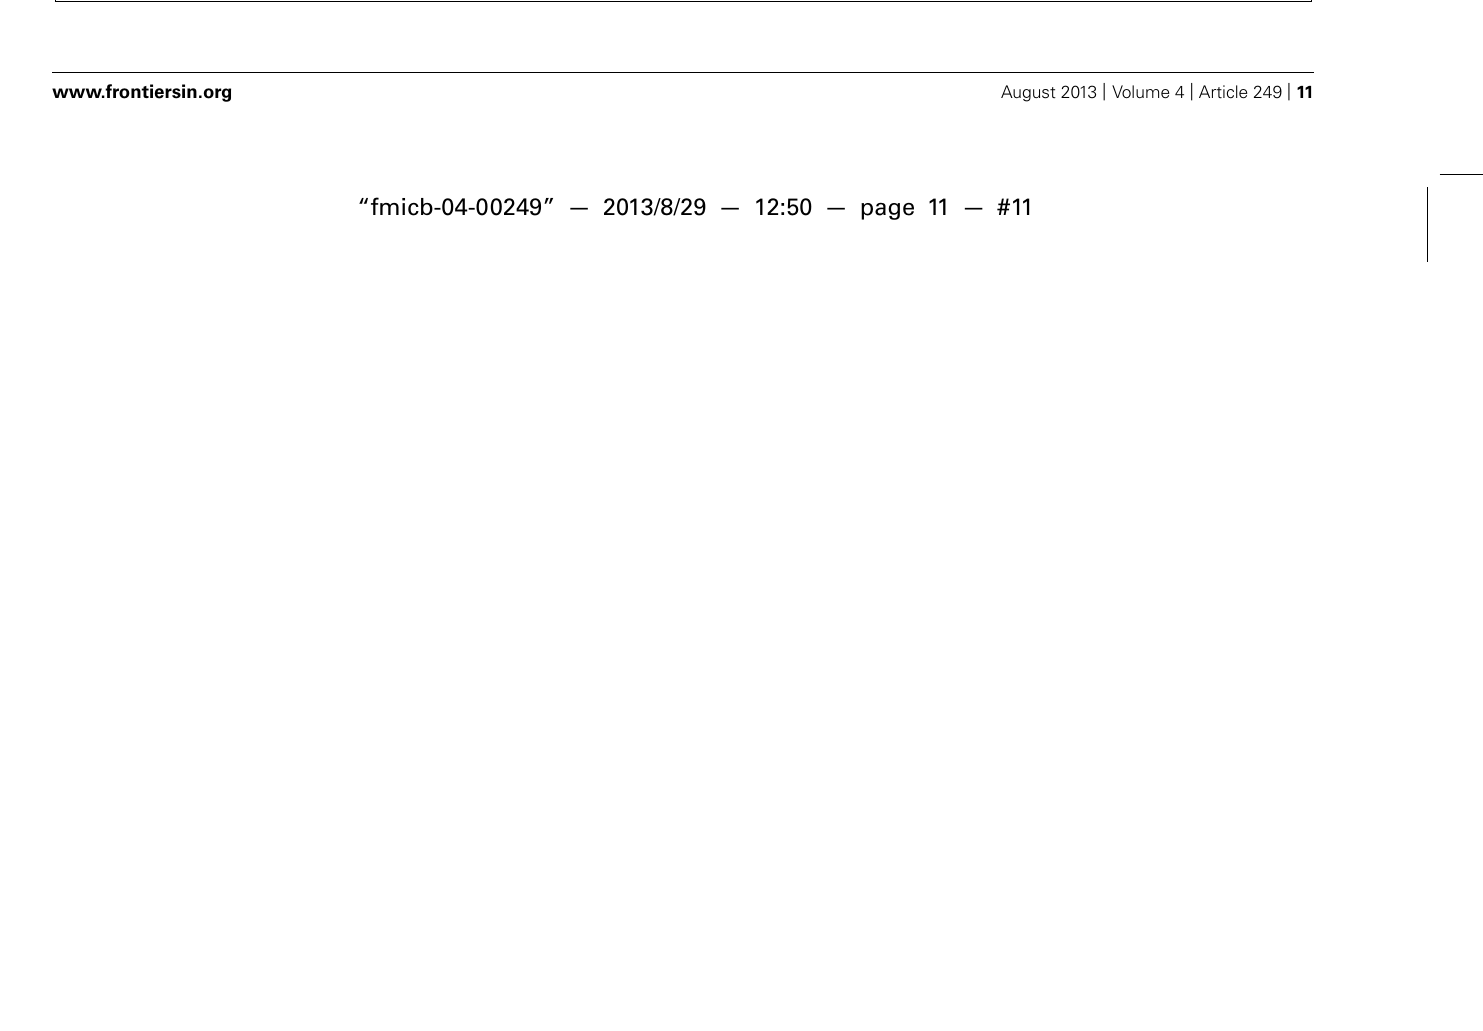
FIGURE 4 |Volcano plots of log 10 odds of differential expression versus log 2 fold differential expression for all T. denitrificans genes under nitrate-dependent UO 2 -oxidizing (A), FeCO 3 -oxidizing (B), and Fe 2 + -oxidizing (C) conditions (GroupsVI,V, and II, respectively;Table 1)